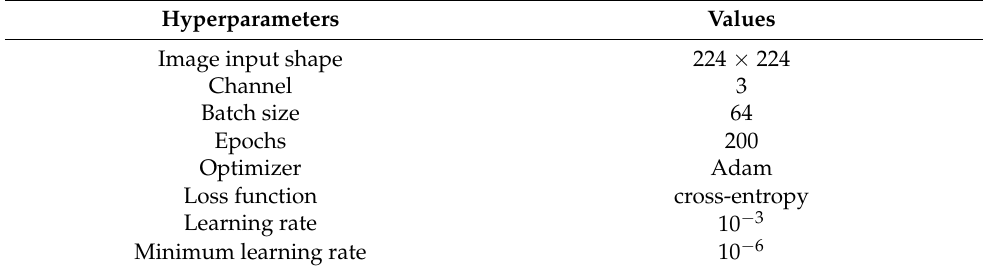
Table 3. Performance of Y_PN-MSSD model based on different optimizers. Sl. No